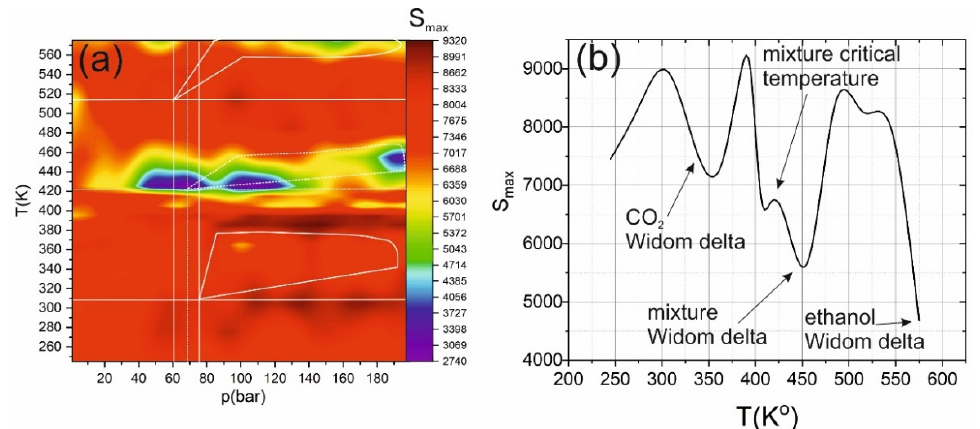
Figure 4. ( a ) Heat map of the maximum cluster size S max (number of molecules) dependence on pressure and temperature. The solid lines show the critical temperatures and pressures of carbon dioxide and ethanol; the white dashed line shows the mixture critical point. The highlighted areas correspond to the Widom delta (solid lines for carbon dioxide and dashed lines for mixtures). ( b ) Dependence of the maximal cluster size on temperature under pressure of 161 bar.